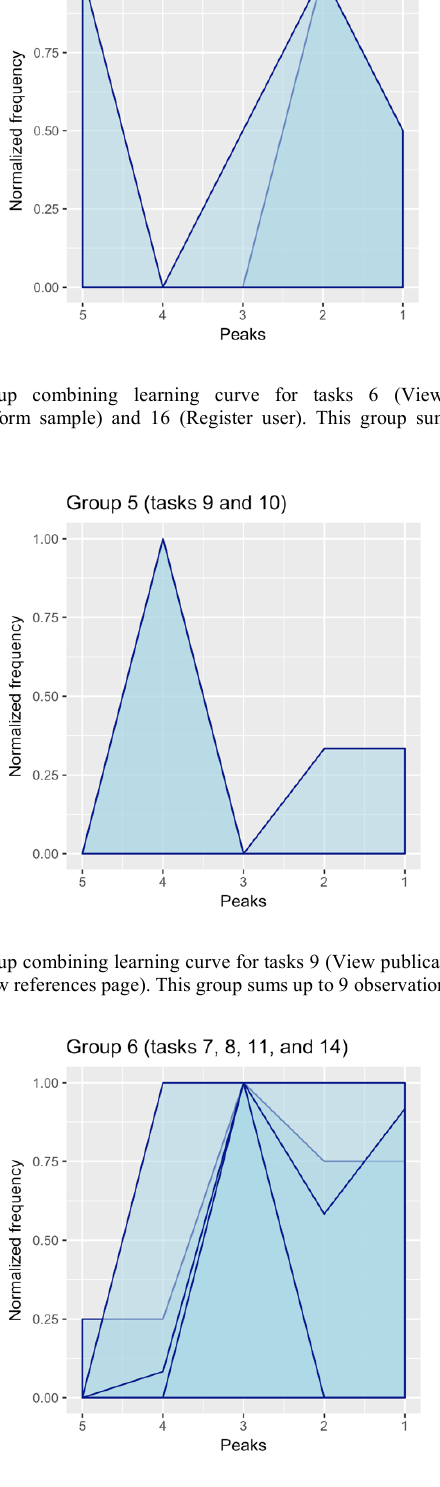
Fig. 13. Group combining learning curve for tasks 7 (View topics index), 8 (Create an accessibility evaluation), 11 (Access the administration page), and 14 (Delete content). This group sums up to 70